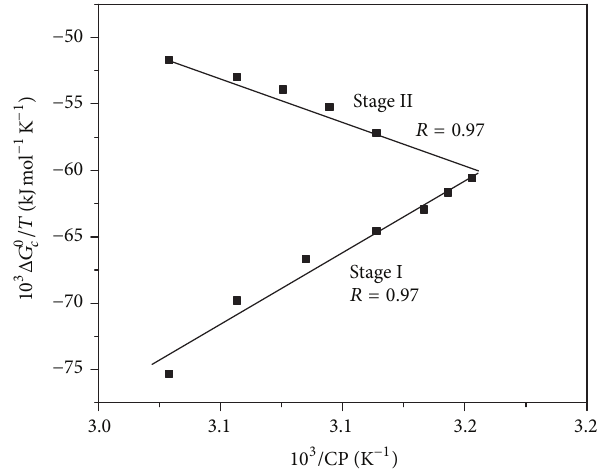
Figure 5: Δ𝐺 0 𝑐 /𝑇 versus 1/𝑇 plot of the NORT-HPMC system in presence of 100mMNaCl (type